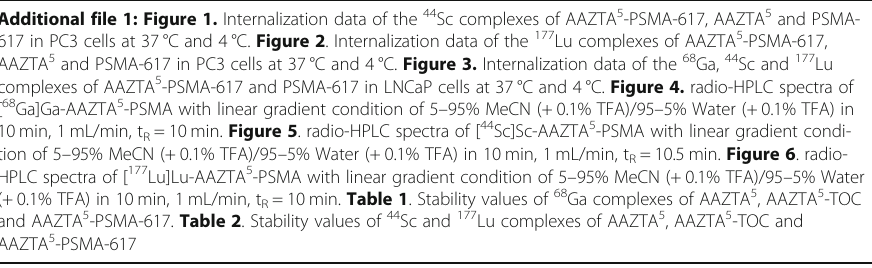
Additional file 1: Figure 1. Internalization data of the 44 Sc complexes of AAZTA 5 -PSMA-617, AAZTA 5 and PSMA- 617 in PC3 cells at 37°C and 4°C. Figure 2 . Internalization data of the 177 Lu complexes of AAZTA 5